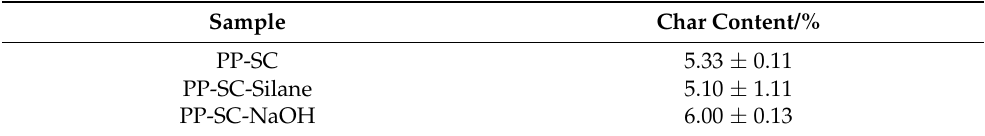
Table 2. Char content values for all PP-SC-composites.